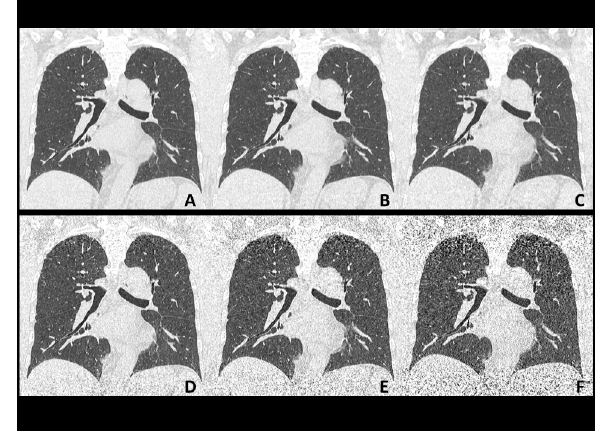
Figure 2. Reconstructed coronal plain chest CT images (56- year-old male weighing 62 kg). Images are arranged as in Figure 1 ( A–C , with AIDR3D; D–F , without AIDR3D; A and D , at 240 mA; B and E , at 120 mA; C and F , at 60 mA). Severe image noise was observed at the upper lung zones and bottoms at 120 and 60 mA without AIDR3D ( E and F ), which was obviously improved using AIDR3D ( B and C